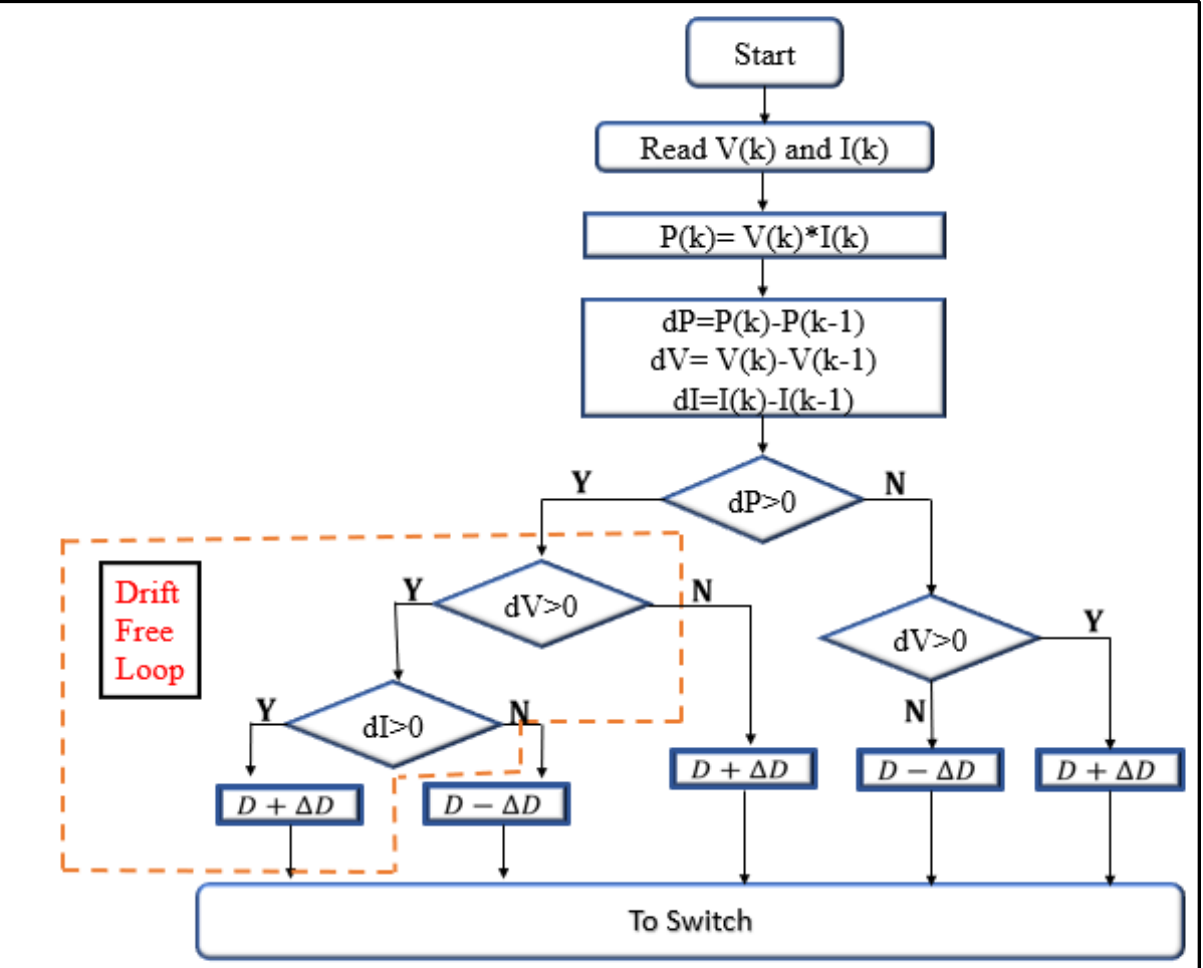
Figure 6. The flowchart of the modified DC-(P&O) technique.